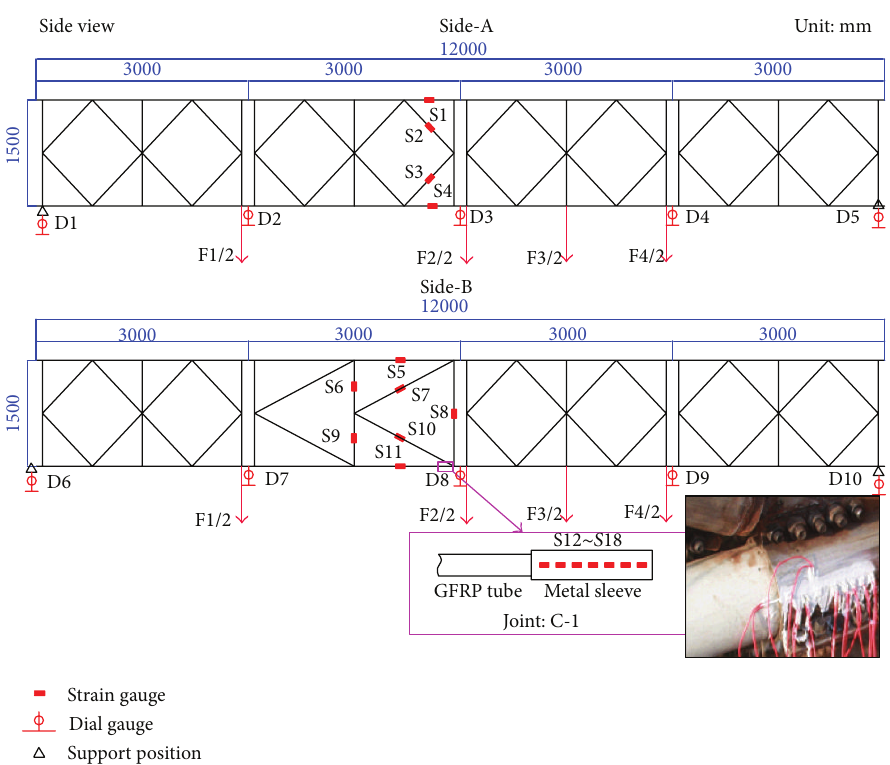
Figure 10: Static live loading position and sensor